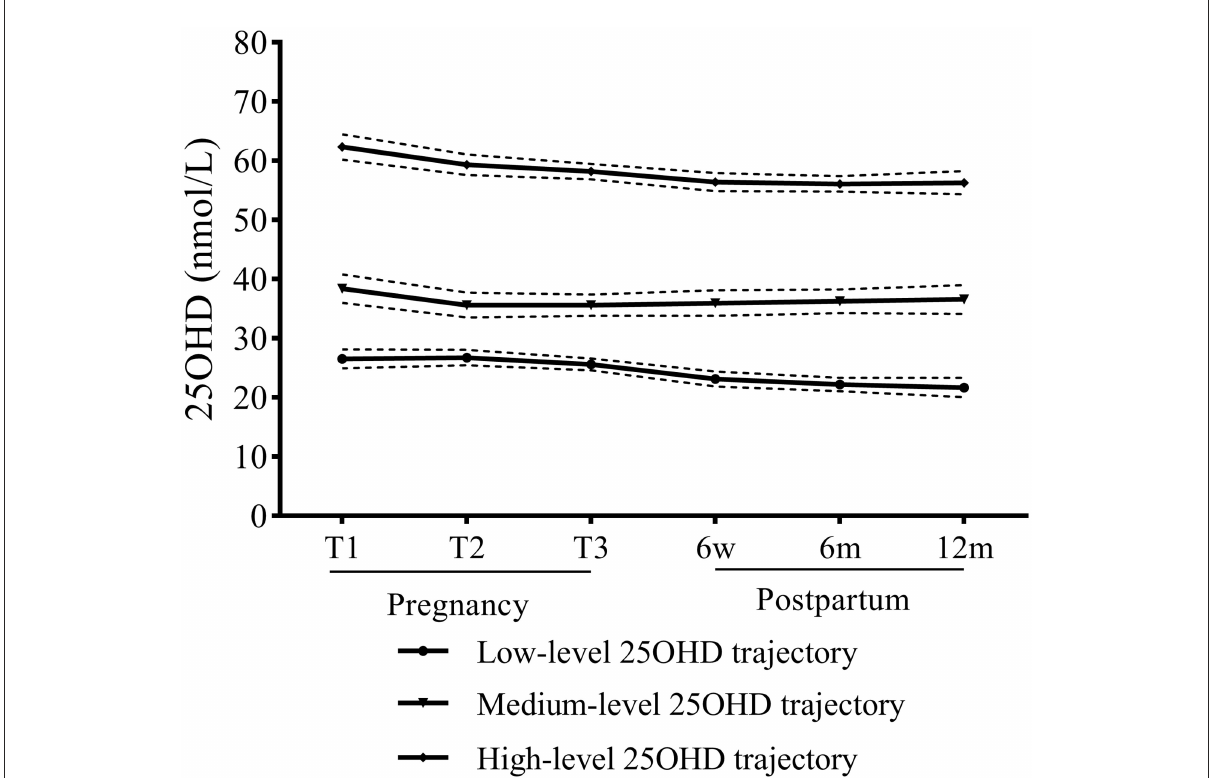
FIGURE3 Trajectories of serum 25OHD of hypothyroidism women during pregnancy and 1-year postpartum.